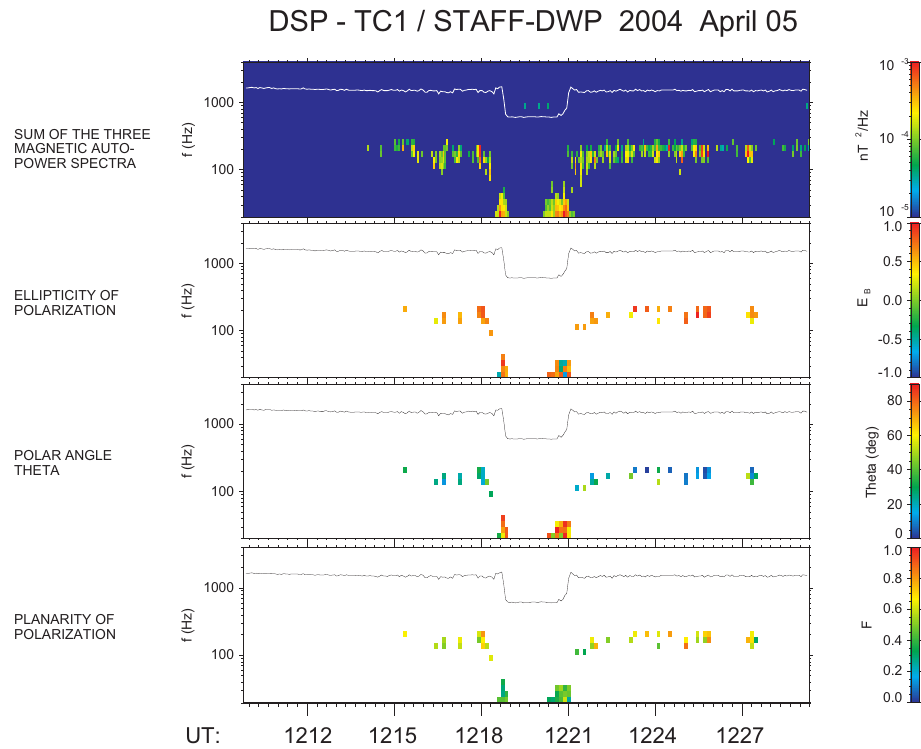
Fig. 8. Results of the PRASSADCO analysis of the same event as in Fig. 7. From top to bottom are plotted, in frequency-time the total power spectra, the ellipticity of polarization (+1=circular right-handed , 0=linear, –1=circular left-handed), the polar angle θ (0=k parallel to B 0 ) and the planarity (1=plane waves). These wave polarization characteristics, color coded, are plotted only above a given wave power threshold. The electron gyrofrequency is over plotted on the dynamic spectra, showing clearly a reduced value in the solar wind. Whereas the polarization characteristics are confused for the turbulence at the shock, the lion roars are clearly right hand polarized, and propagate close to the magnetic field, θ< 10 ◦